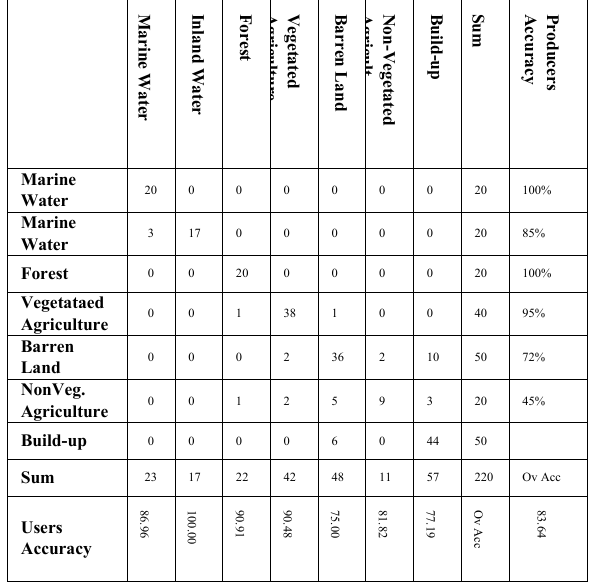
Table 1. Accuracy